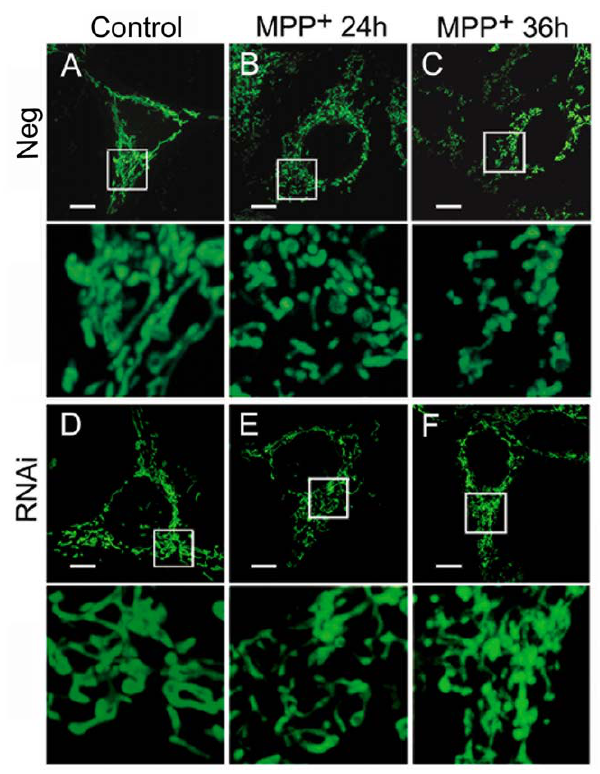
Figure 7. The effects of a -synuclein suppression on mitochon- drial morphology in SH-SY5Y cells. Representative images taken by live cell imaging system show no obvious alteration in mitochondrial morphology between Neg group (A) and RNAi group (D). MPP + (1 mM) induces severe mitochondrial fragmentation in Neg group (B and C) but has little effect on mitochondrial morphology in RNAi group (E and F). Scale bar for 10 m m.